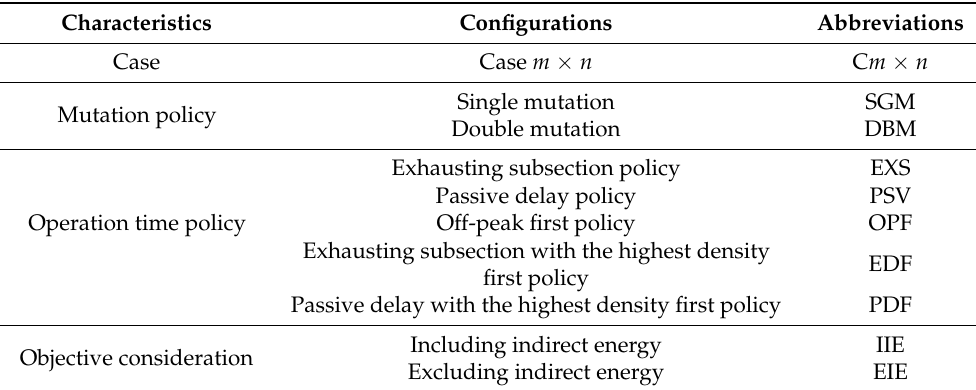
Table 5. Abbreviations of the characteristic configurations for the